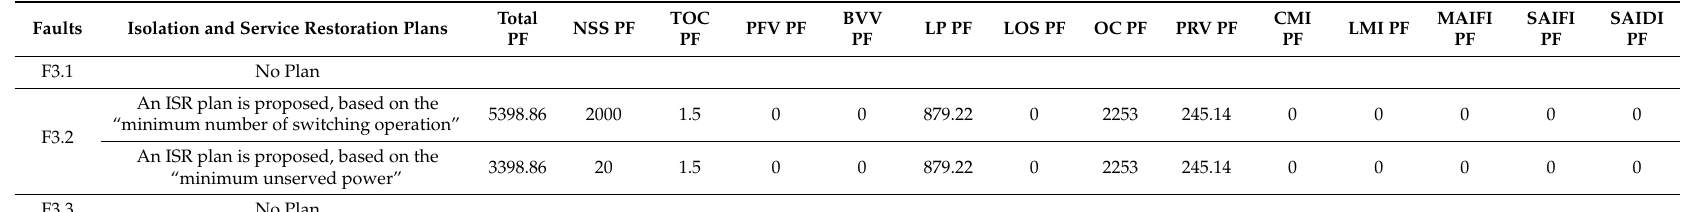
Table 25. Performance factors for each ISR plan at